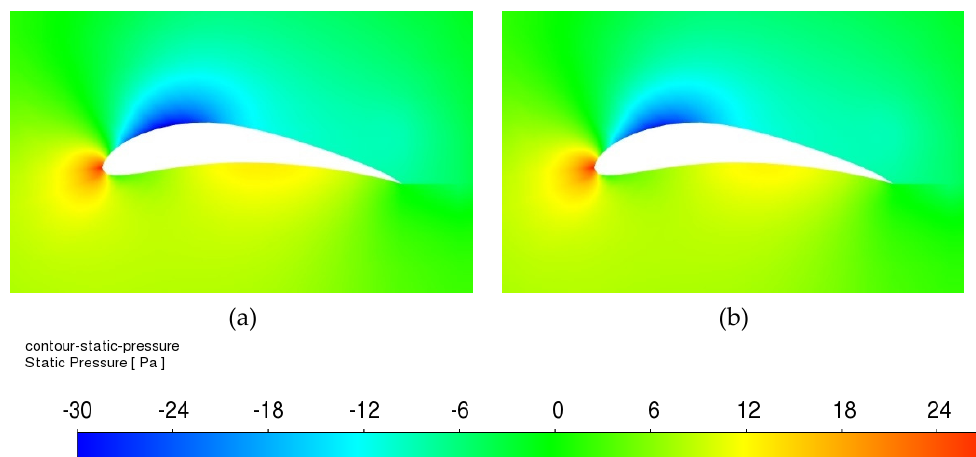
(f) Figure 16. Comparison between one-phase and two-phase flow (air–sand) ( a ) Lift coefficient of wing in a structured mesh ( b ) Lift coefficient of wing in a subsonic wind tunnel ( c ) Drag coefficient of wing in a structured mesh ( d ) Drag coefficient of wing in a subsonic wind tunnel ( e ) Aerodynamic efficiency of wing in a structured mesh ( f ) Aerodynamic efficiency of wing in a subsonic wind tun- nel.